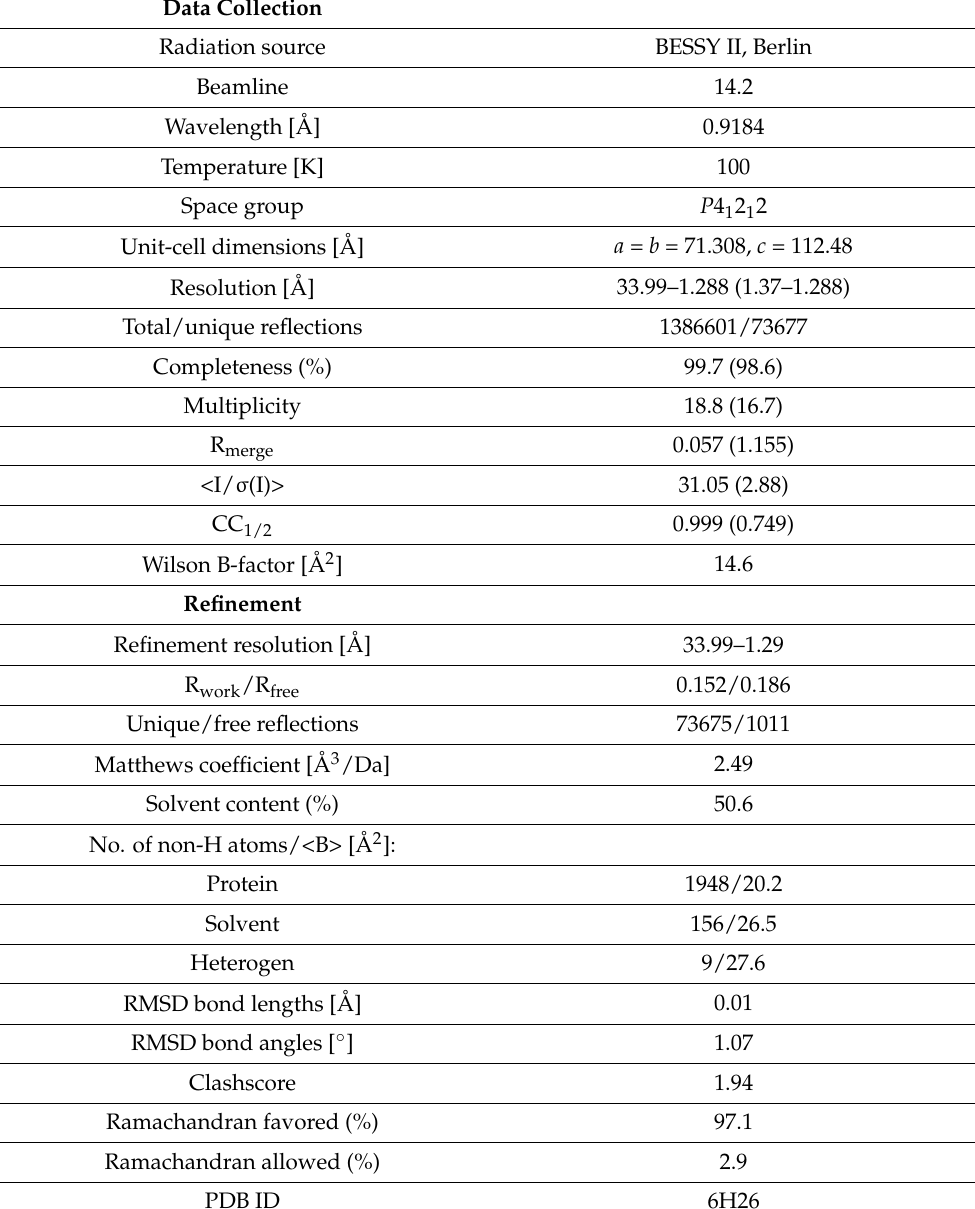
Table 1. Details of X-ray data collection and refinement. Numbers in parentheses refer to the highest resolution